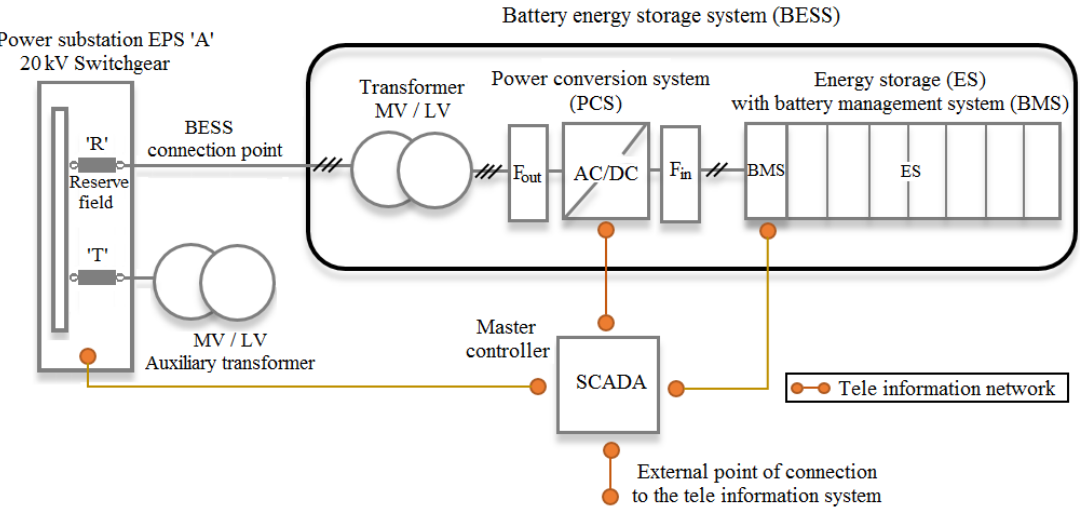
Figure 5. Simplified structure of the BESS.